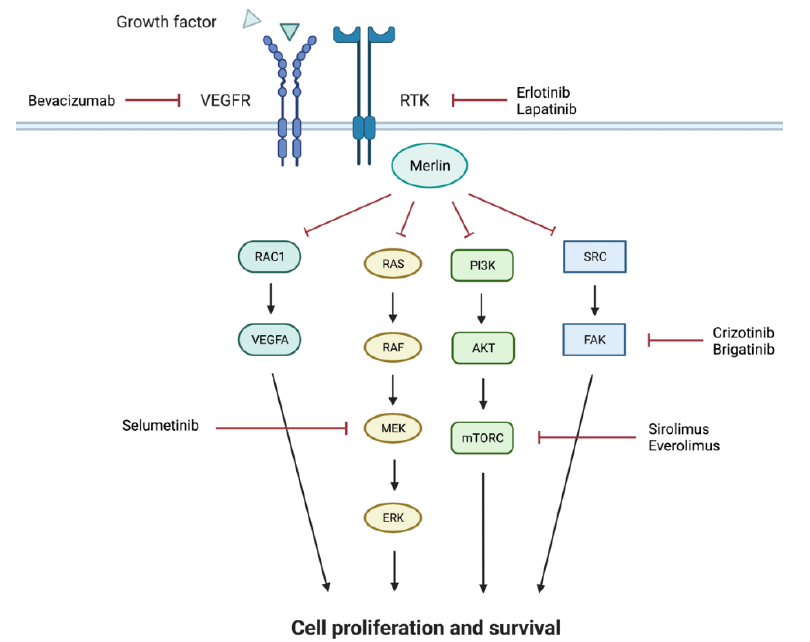
Figure 2. Simplified schema of the signaling pathways implicated in tumor formation with loss of merlin, the protein product of NF2. Therapies utilized to target these activated pathways are noted. This figure was created with Biorender.com (accessed on 19 October 2021).